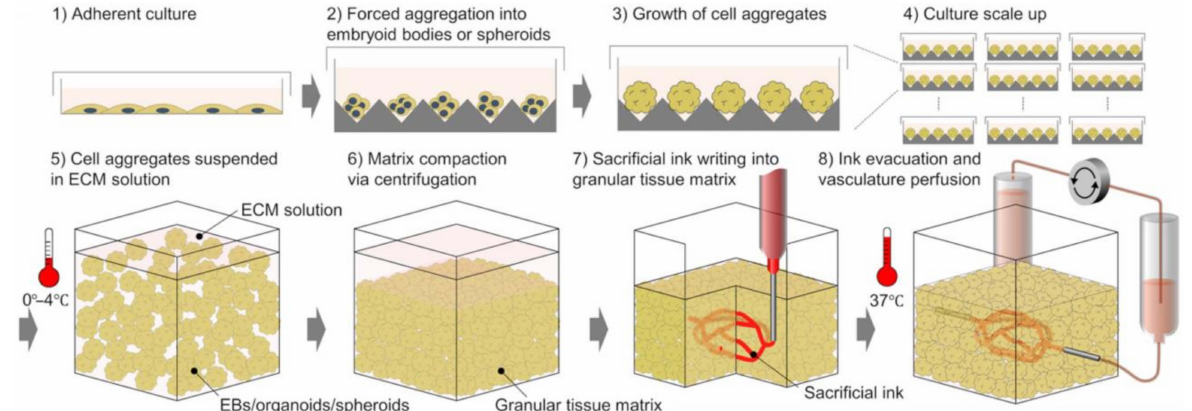
Figure 5. Schematic representation of the SWIFT process. Copyright © 2023 The Authors [62], some rights reserved, exclusive licensee American Association for the Advancement of Science. Distributed under a Creative Commons Attribution Non-Commercial License